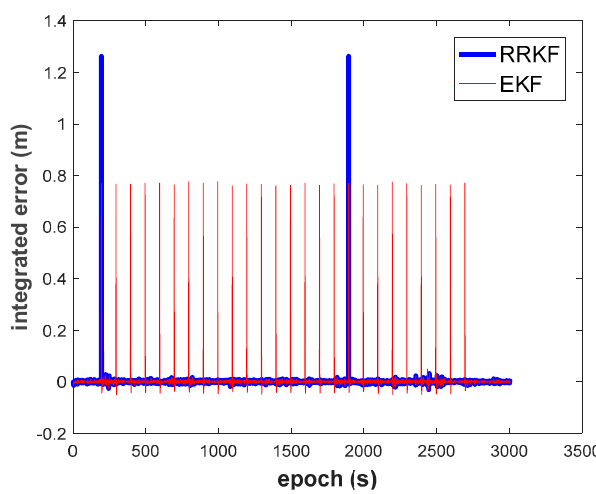
Figure 19. Small dense observation outliers detecting with ORBF strategy.